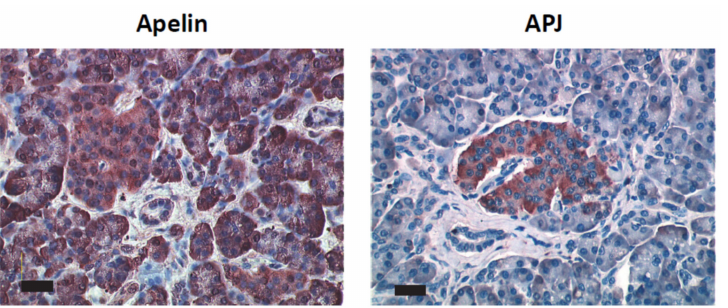
Figure A1. Expression pattern of Apelin and APJ in a healthy human pancreas. Immunohistochem- istry realized on a human pancreas using anti-apelin (left panel) or anti-APJ (right panel) antibodies. Scale bar, 34 µ